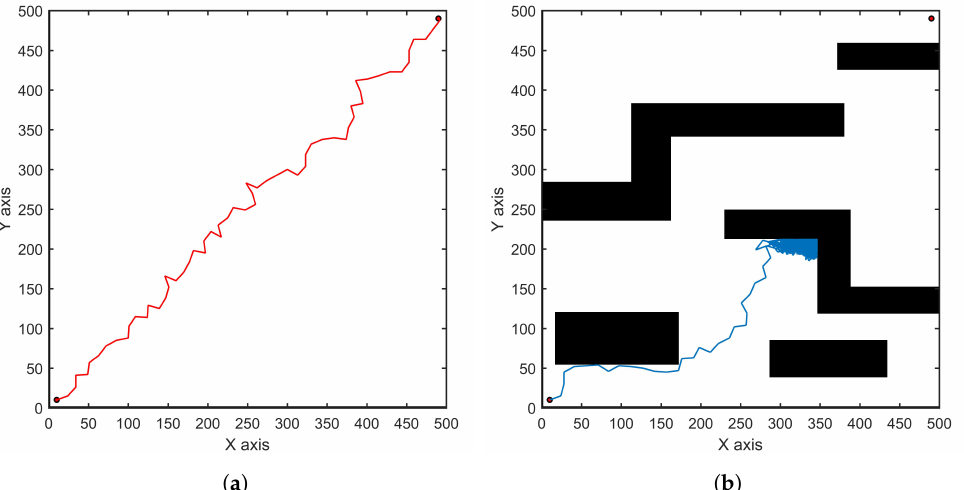
Figure 3. Under a control value of one and the combination of the exploration with the CSA method, the random tree exhibits different behaviors when it does and does not encounter obstacles. ( a ) Efficient exploration in an environment without obstacles. ( b ) The “local trap” phenomenon during exploration in an environment full of